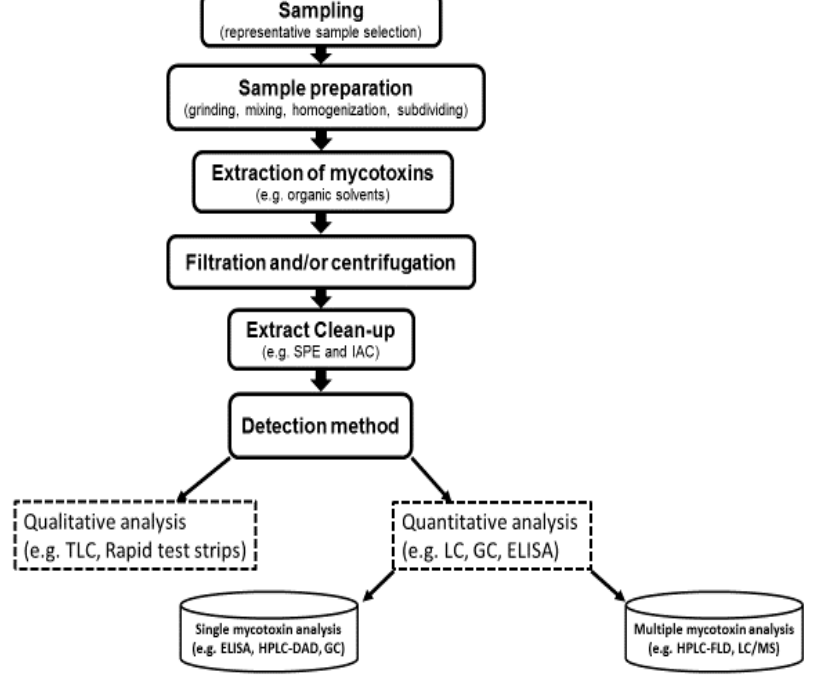
Figure 7. Flow diagram of common steps involved in mycotoxins analysis in food commodities.